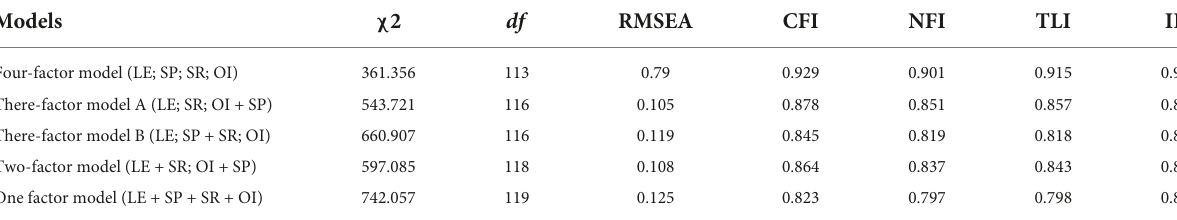
TABLE 2 Measure model